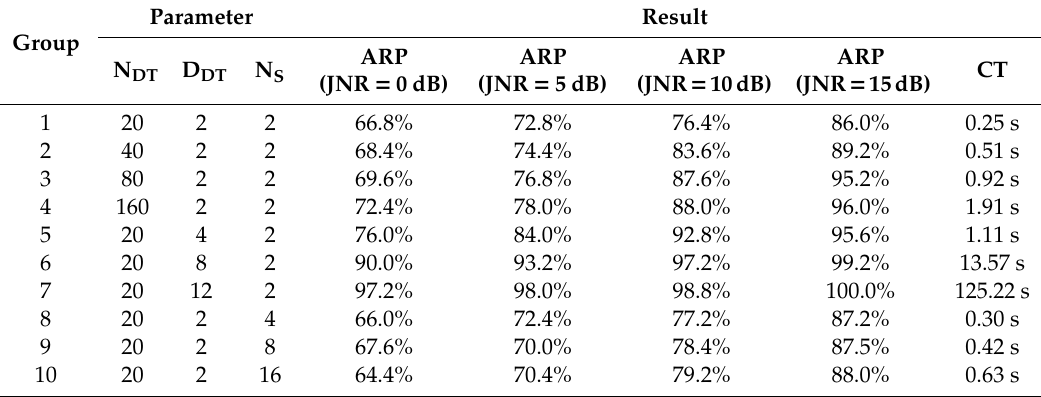
Figure 12. Random-forests (RF) structure diagram. ( a ) Training process; ( b ) test process. Table 3. Recognition performance based on the RF classifier. Note: ARP, average recognition probability; CT, computational